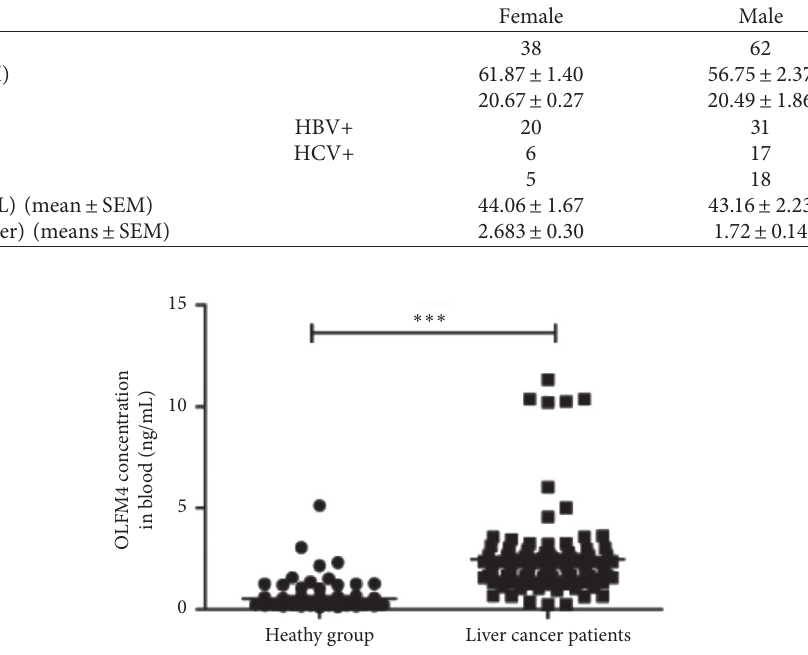
Table 3: Basic physiological characteristics of HCC.